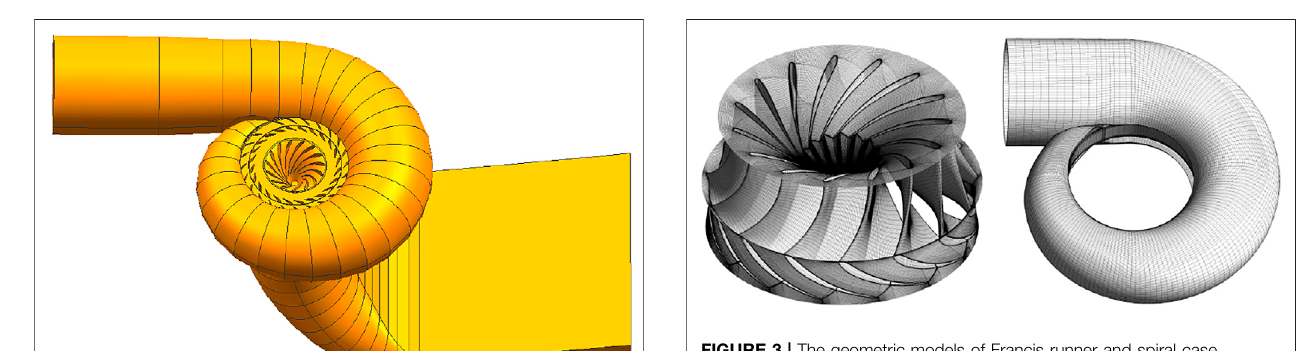
FIGURE 3 | The geometric models of Francis runner and spiral